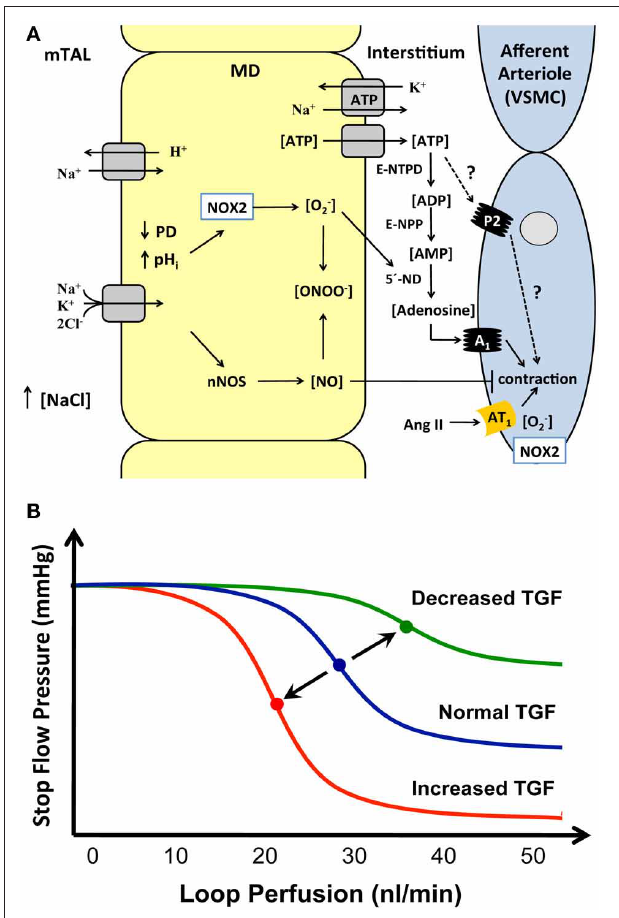
FIGURE 1 | (A) Suggested mechanisms by which increased concentration of NaCl at the macula densa site increase apical Na/K/2Cl co-transporter and the Na/H–exchanger that will depolarize basolateral cell membrane potential which will activate NADPH oxidase 2 (NOX2) to increase production of O − 2 , but also increase NO production rate from nNOS. At the same time swelling of the macula densa cells can increase ATP leakage. ATP can then be broken down through ecto-5 (cid:2) -nucleotidase (5 (cid:2) -ND) and thereby increase the concentration of adenosine, this process can also be stimulated by O − 2 . The NO released could counteract the production of O − 2 by forming peroxynitrite and in this way counteract the sensitization of the TGF. NO could also act directly on the AA to reduce the contractile response elicited by adenosine and angiotensin II (Ang II). Figure modified from that published in Carlstrom and Persson (2009). A 1 ,